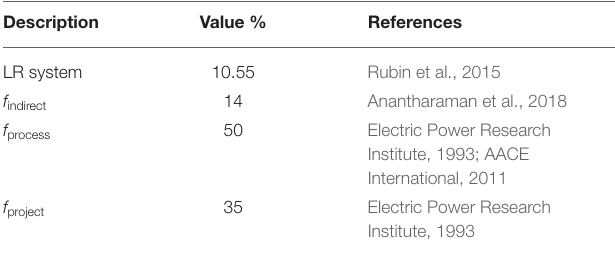
TABLE 2 | Assumed indirect costs, contingencies, and learning rates for system (guidelines for deriving project and process contingencies are shown in Tables 3 ,